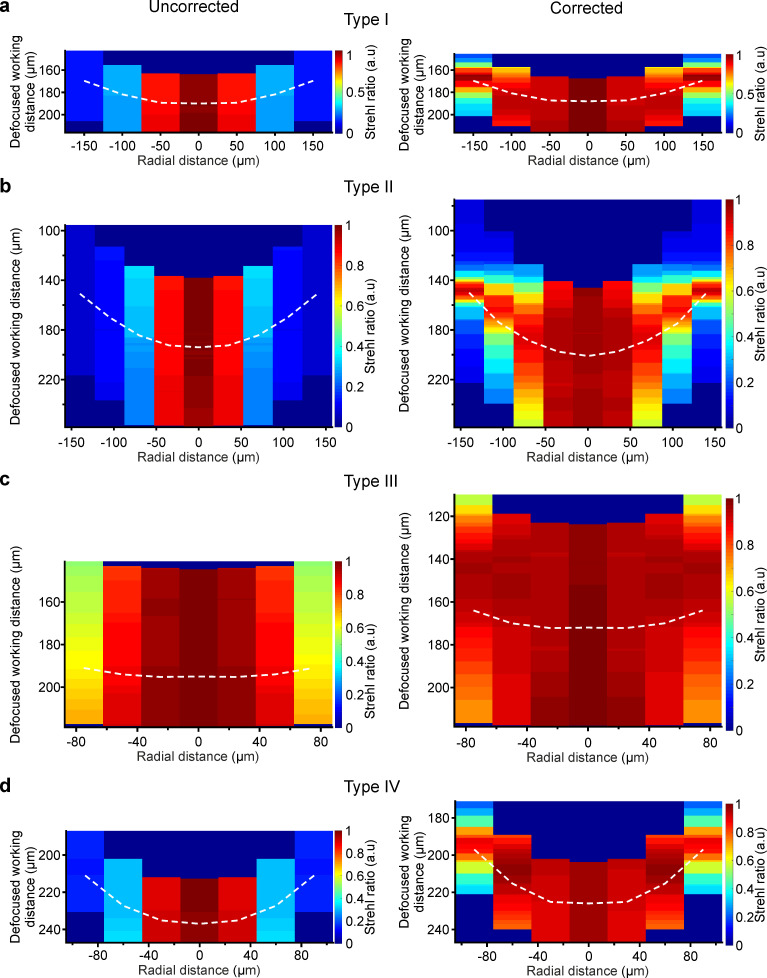
Corrective lenses enlarge the simulated volume that can be scanned during 3D imaging.(a) Pseudocolor map showing the simulated Strehl ratio on a x,z section of the image space for type I uncorrected (left) and corrected (right) microendoscopes. The dashed white line represents a section of the imaging plane for which the corrective lens profile was optimized. In the case of uncorrected microendoscopes, it represents the section obtained with the same optical configuration, but without the corrective lens. (b) Same as in (a) for type II microendoscopes. (c) Same as in (a) for type III microendoscopes. (d) Same as in (a) for type IV microendoscopes.Figure 2—figure supplement 3—source data 1.Simulated Strehl ratio as a function of the lateral and axial displacement for type I-IV uncorrected and corrected microendoscopes.